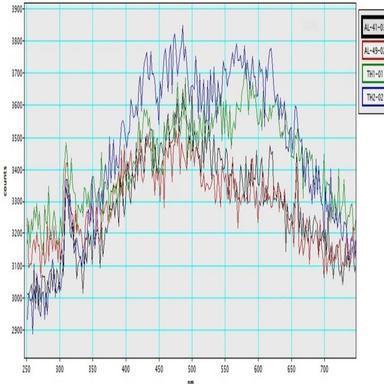
Representative CL spectra of the glazes of the archaeological samples (black and red lines) and the authentic replicas (green and blue lines). Analyses carried out on small areas of each glaze (approximately 5 × 5 μm).